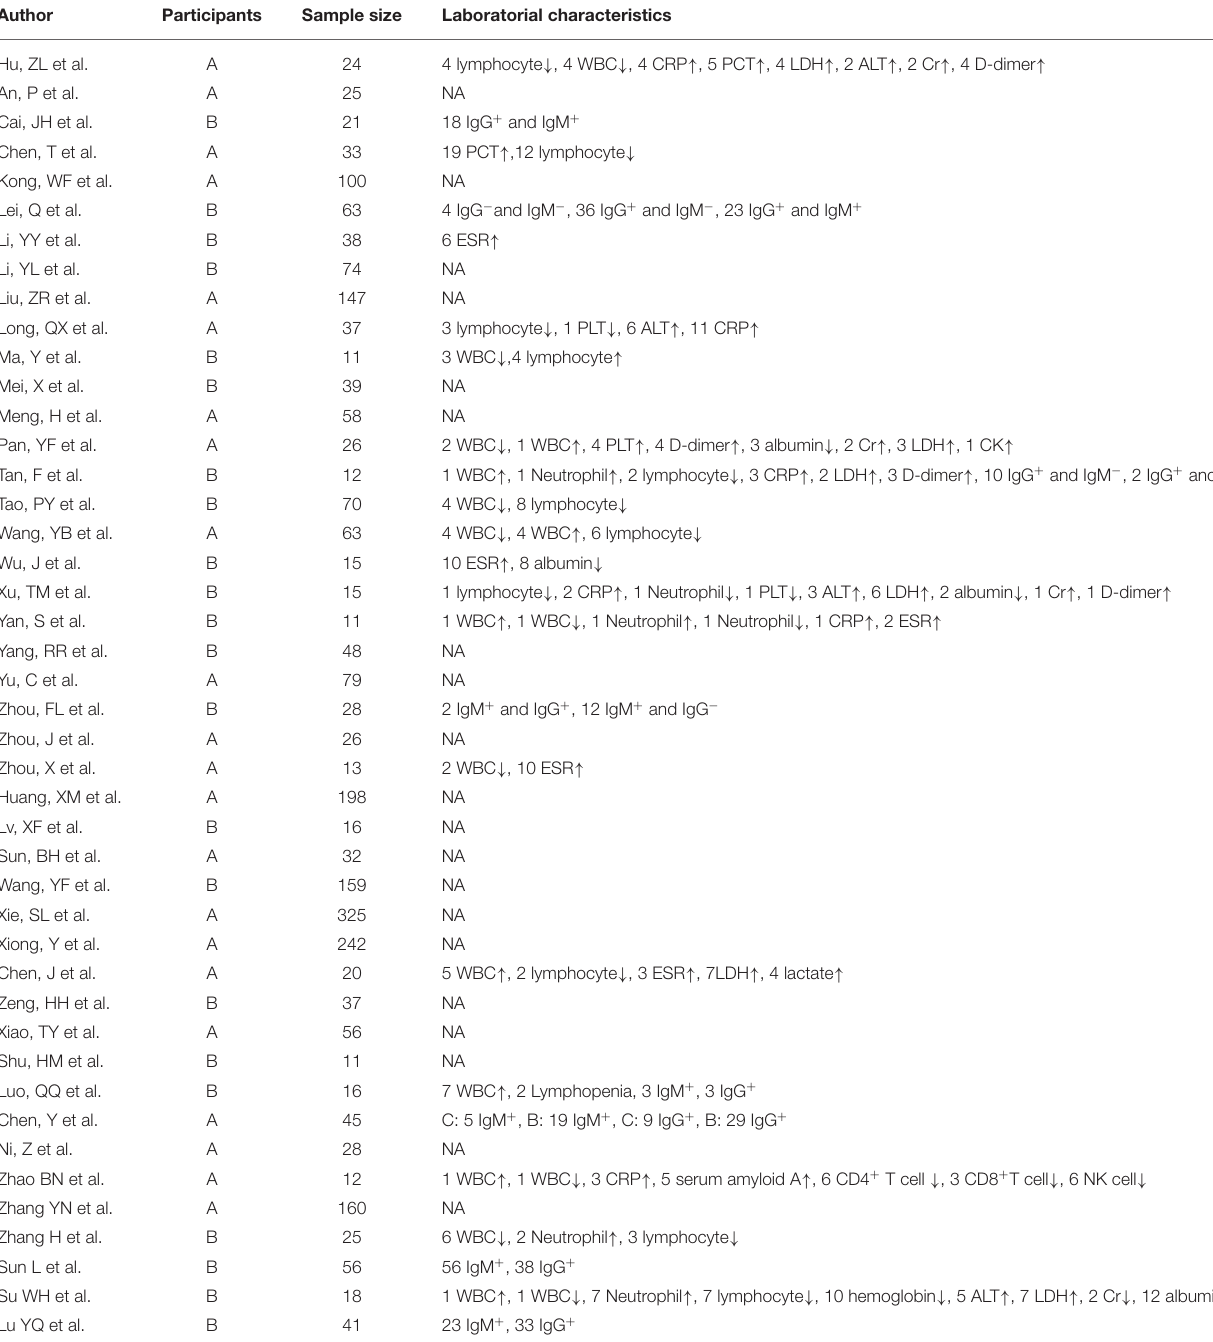
TABLE 1 | Laboratorial characteristics of Chinese asymptomatic cases with COVID-19. Author Participants Sample size Laboratorial